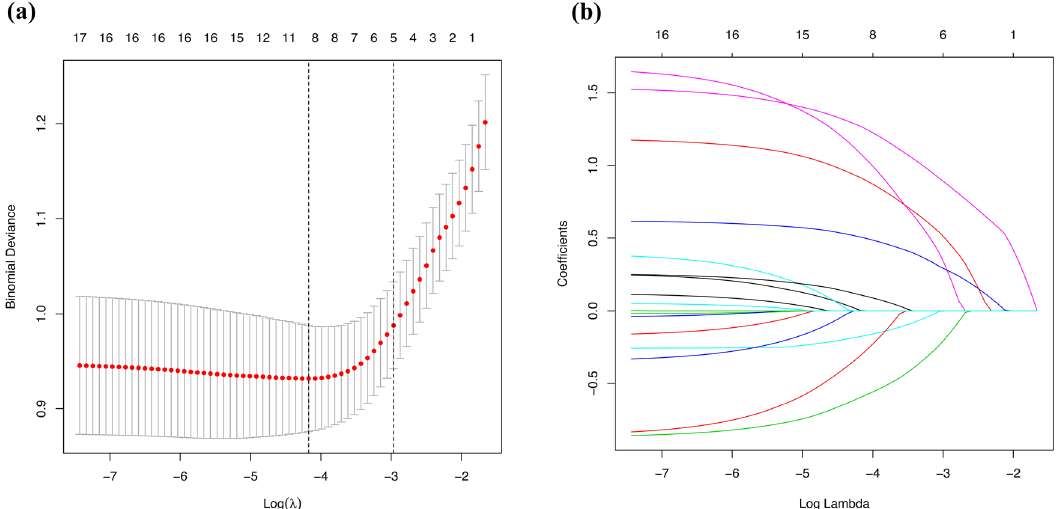
Figure 1: Demographic information, clinical laboratory tests, and pathological examination selection using the LASSO binary logistic regression model. ( a ) Optimal parameter ( lambda ) selection in the LASSO model used 10 - fold cross - validation via minimum criteria. The partial likelihood deviance ( binomial deviance ) curve was plotted versus log ( lambda ) . Dotted vertical lines were drawn at the optimal values using the minimum criteria and the 1 SE of the minimum criteria ( the 1 - SE criterium ) . ( b ) LASSO coe ffi cient pro fi les of the 17 features. A coe ffi cient pro fi le plot was produced against the log ( lambda ) sequence. Vertical line was drawn at the value selected using 10 - fold cross - validation, where the optimal lambda resulted in nine features with non - zero coe ffi cients. Abbreviations: LASSO, least absolute shrinkage and selection operator; SE, standard